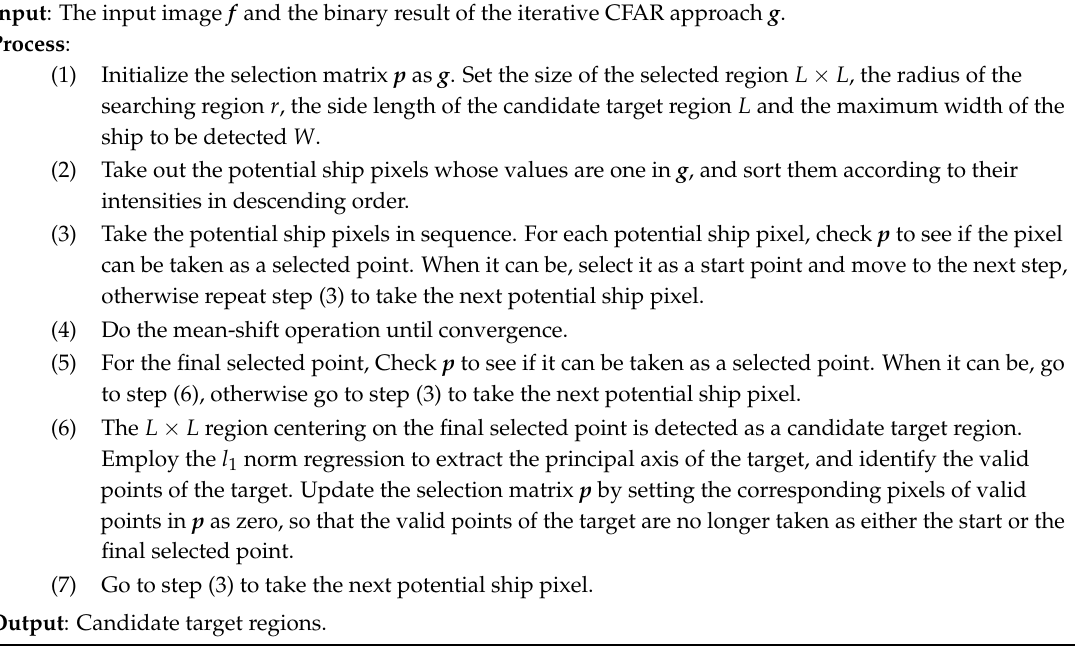
Figure 3. Detected results of the iterative CFAR approach after the first and the fourth iteration.